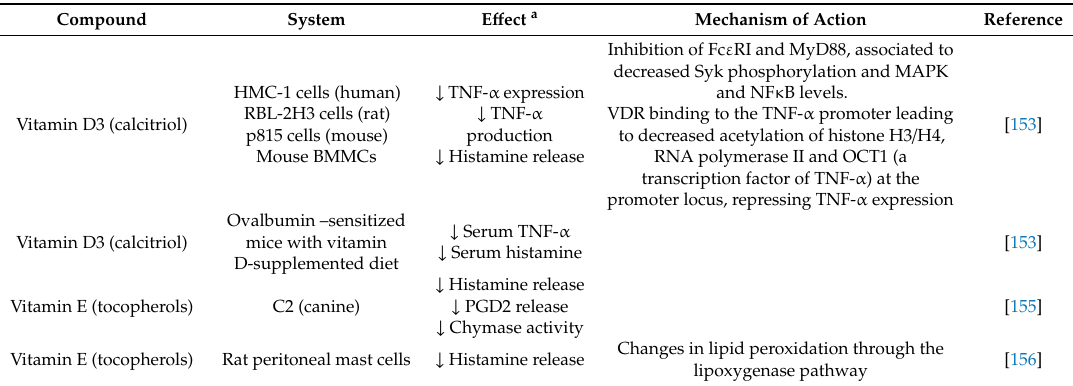
Table 4. Immunomodulatory e ff ects of fat-soluble vitamins on mast cell activity. Compound System Mechanism of